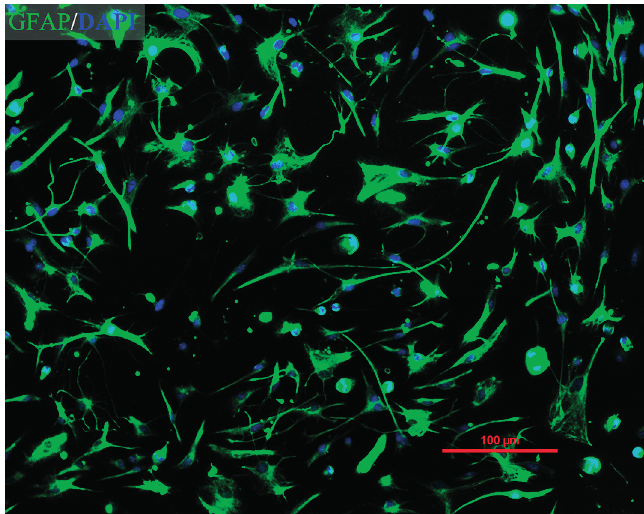
Figure 1. Immuno fl uorescence assay of purified primary rat astrocytes. Merged image of GFAP staining (green) and DAPI staining (blue) (magnification: